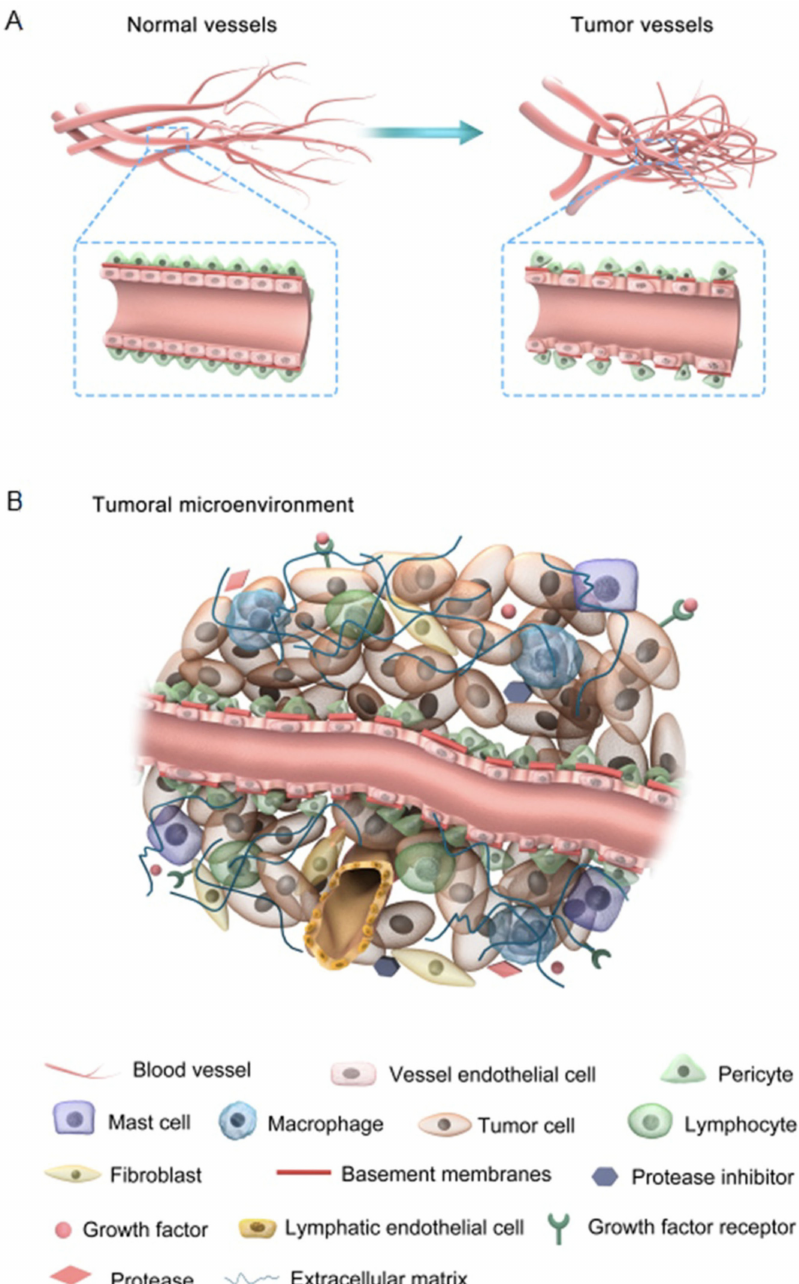
Figure 2. A comparison of normal vs. tumor vasculature ( A ), and constituents of the tumor envi- ronment ( B ); tumor-associated angiogenesis is regulated by a plethora of molecules produced by tumor cells, stromal cells and a variety of immune cells in the tumor microenvironment including T cells, NK cells, macrophages and dendritic cells. These molecules include growth factors, cytokines, chemokines, interleukins, lipid derivatives, ECM components and epigenetic regulators such as microRNAs carried by microvesicles [64]. The tumor microenvironment is heterogeneous depending on the tumor type and stage of tumor growth. Figure reproduced with permission from